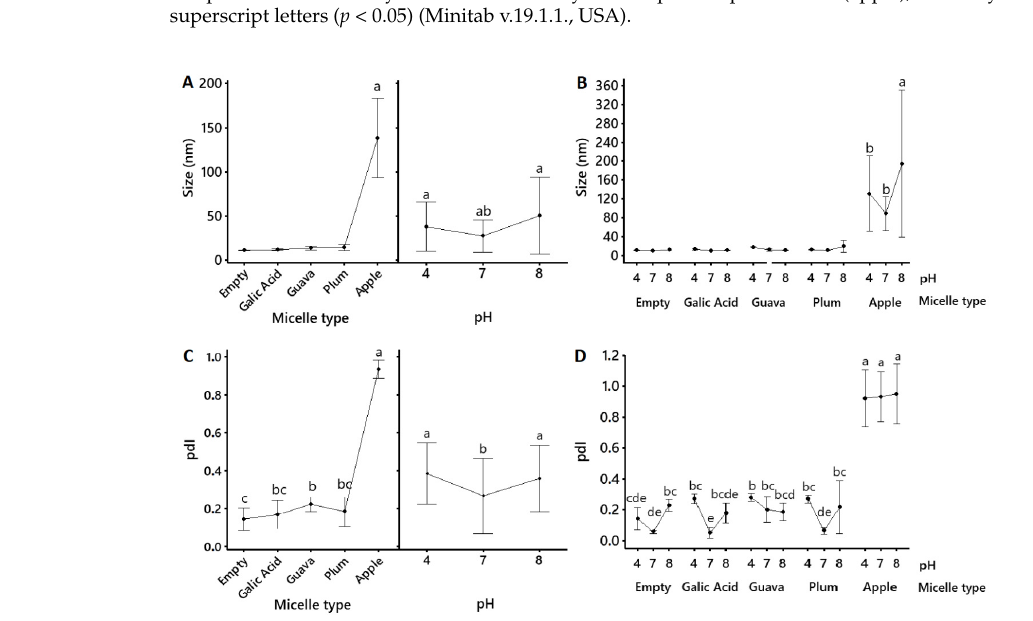
Figure 2. Mean values (mean ± 95% confidence interval, n = 6) for the size (nm) ( A , B ) and polydispersity index (pdI) ( C , D ) of pure gallic acid and apple peel ( M. domestica cv. Anna), plum ( P. domestica cv. Satsuma), and guava ( P. guajava L.) fruit extracts that were solubilized into polysorbate ‐ based micellar formulations. Lines connect mean values. Inserts within ( A ) show the mean size of each micellar formulation (regardless of the pH) on the right and the mean size of all micellar formulations (regardless of the content) on the left. Empty refers to the non ‐ loaded micellar formulation. Statistical differences between the type of micellar fruit extract, the pH, and the type of micellar fruit extract x pH were determined using a General Lineal Model, followed by Bonferroni´s multiple comparison post ‐ hoc tests, and they are indicated by superscript letters ( p < 0.05) (Minitab v.19.1.1., USA).